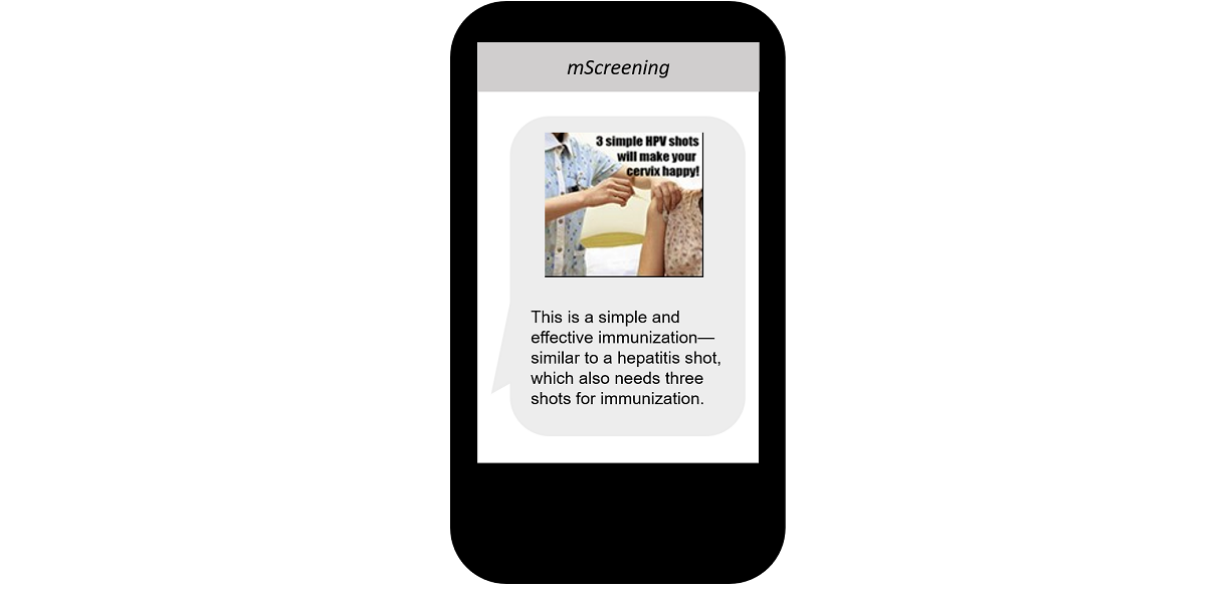
Figure 6. Mobile screening message example: demonstrated the power of visual messages to persuade